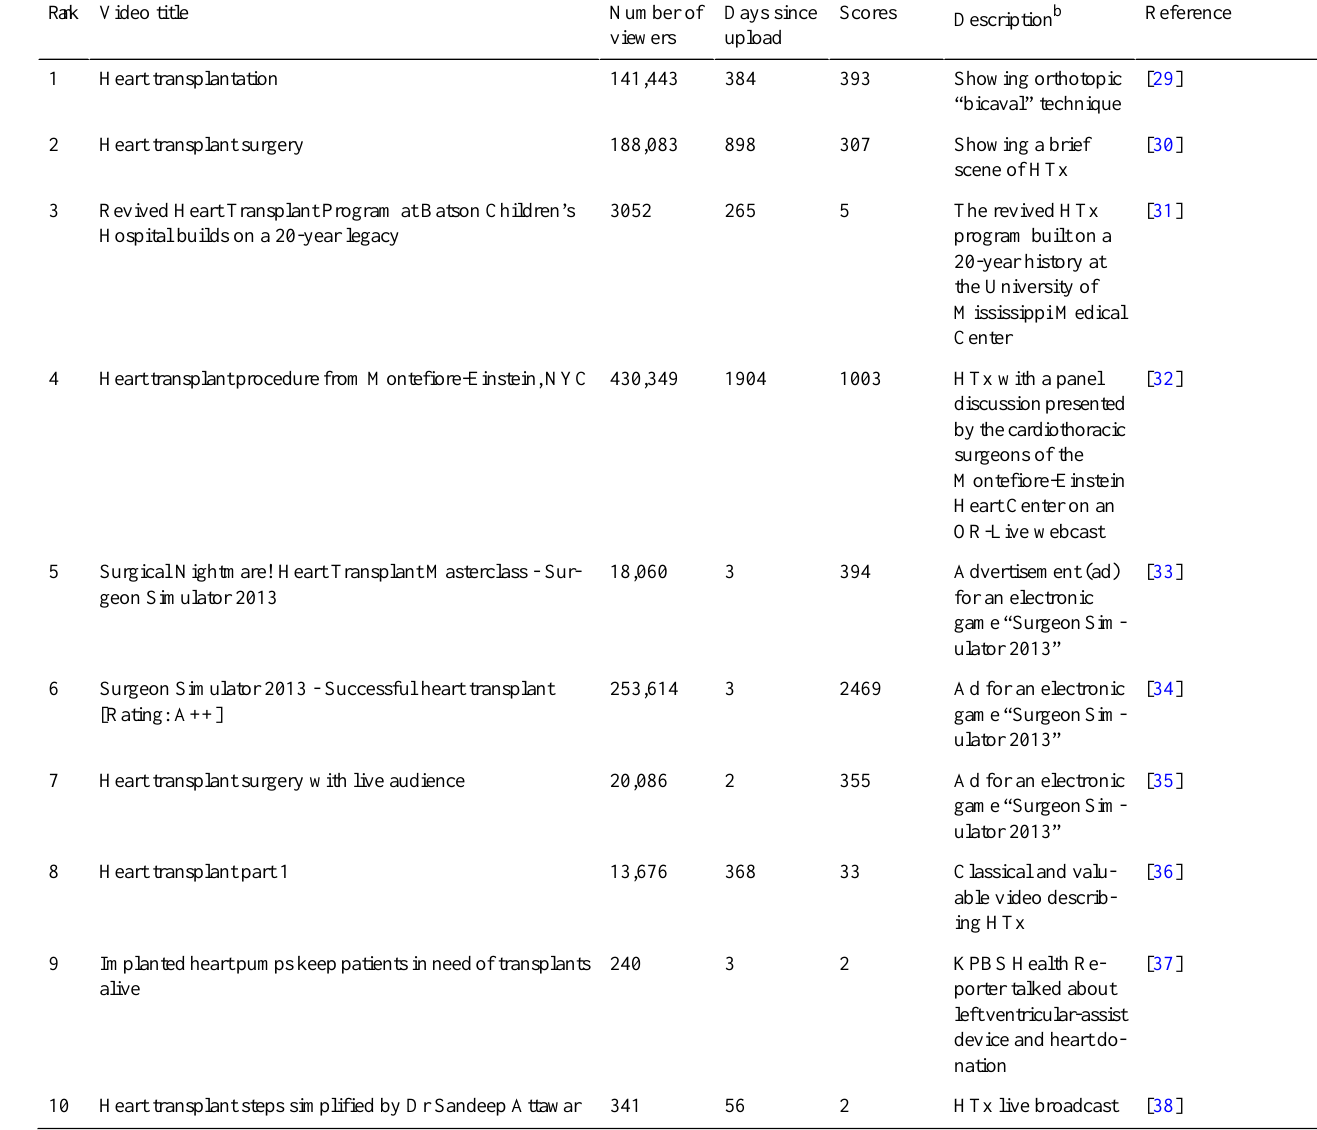
Table 1. A summary of the top ten videos ranked by their “relevance” a resulting from a YouTube search for “heart transplantation” (HTx) on February 01,